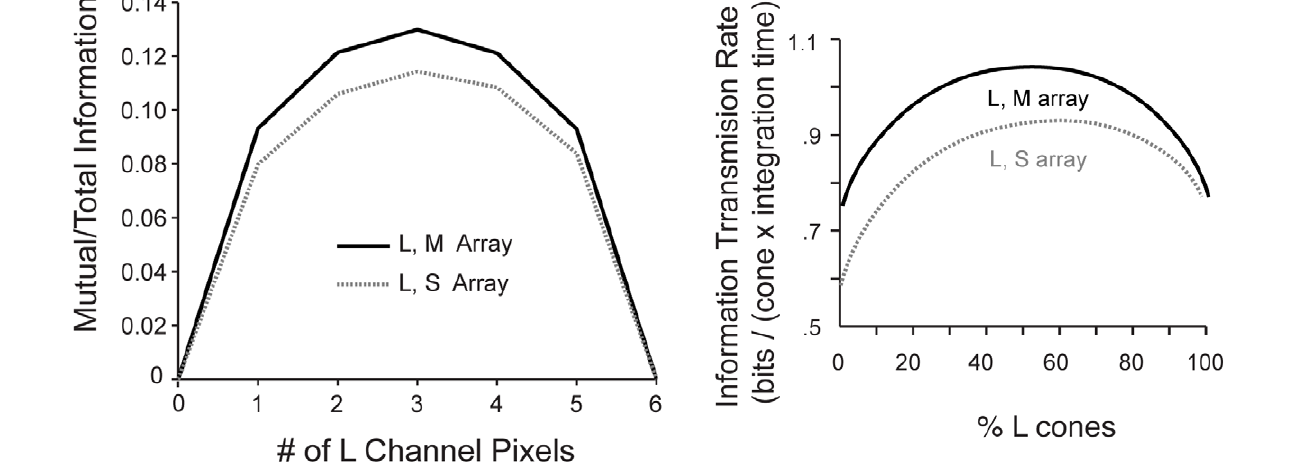
Figure 4. Optimal mosaic for a mixed cone array. Information transmitted by a mixed LM array as a function of the percentage of L cones in the array is shown (solid line), and similarly for an LS array (dotted line). Information represented by a mixed LM array was highest with 52% L cones. Information represented by a mixed LS array was highest with 61% L cones. These results do not include the effects of the human eye’s optics.